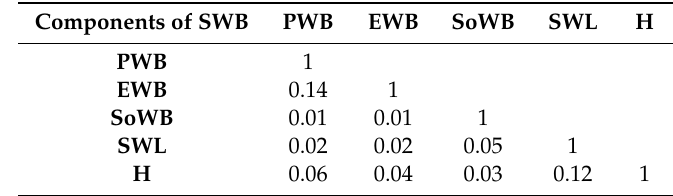
Table 3. Correlation matrix between components of